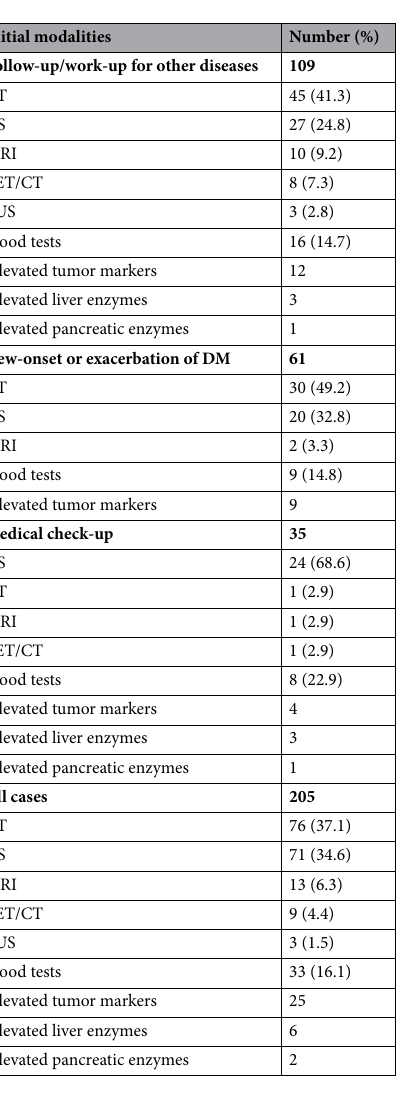
Table 4. Modalities that initially indicated abnormalities in asymptomatic PDAC. CT computed tomography, US ultrasonography, MRI magnetic resonance imaging, PET positron emission tomography, EUS endoscopic